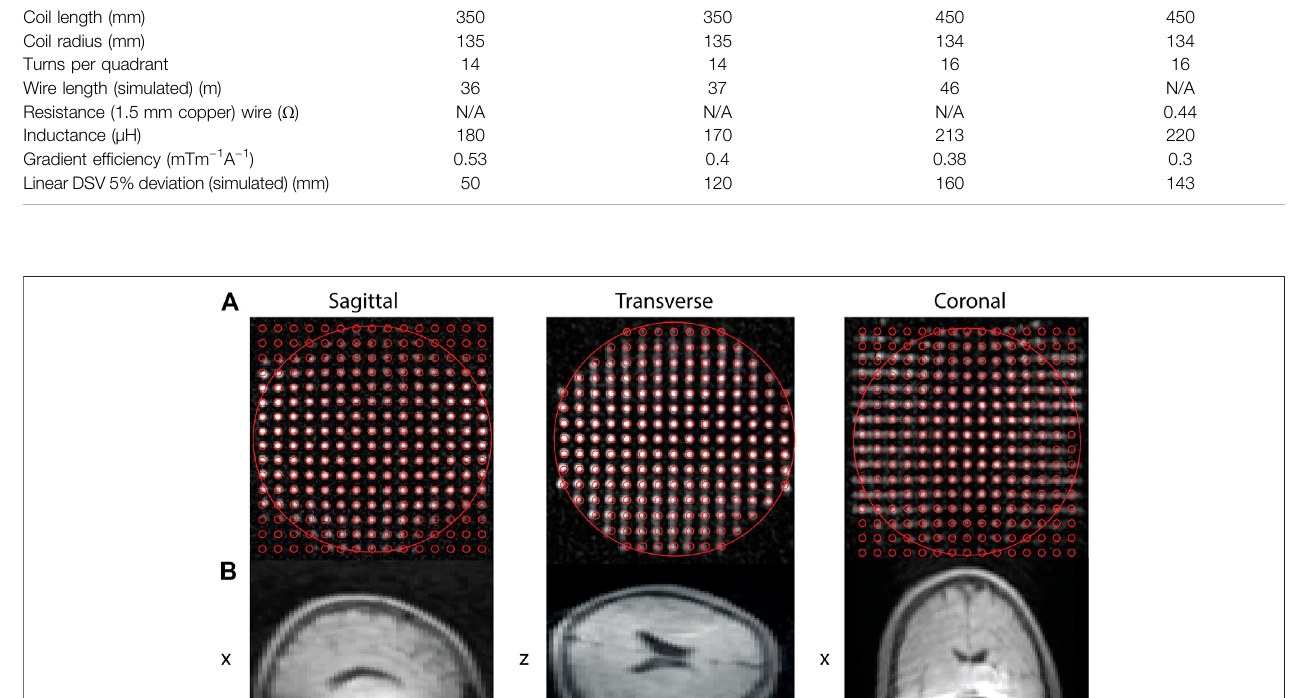
Original method Newmethod (simulations) Constructed gradient coil Constructed gradient coil (simulations) (simulations) (measurements)